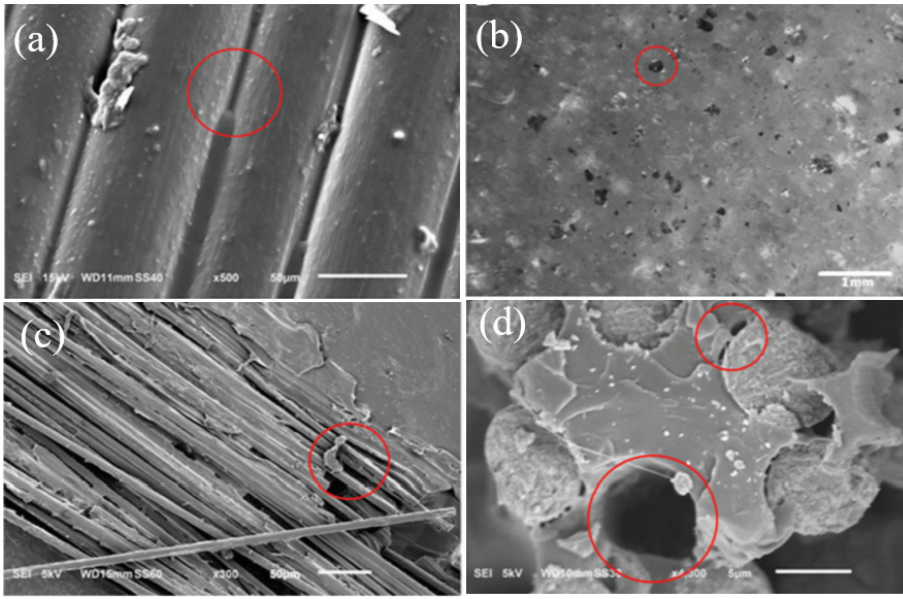
Figure 11. ( a ) Surface roughness of a Nylon sample. ( b ) Micropores on the surface of a PLA sample. ( c ) Poor resin infusion into fibres. ( d ) Fibre pull ‐ out from the matrix [189]. ( c ) Poor resin infusion into fibres. ( d ) Fibre pull-out from the matrix [189]. Some of the void formation in FDM is inevitable due to the nature of this printing